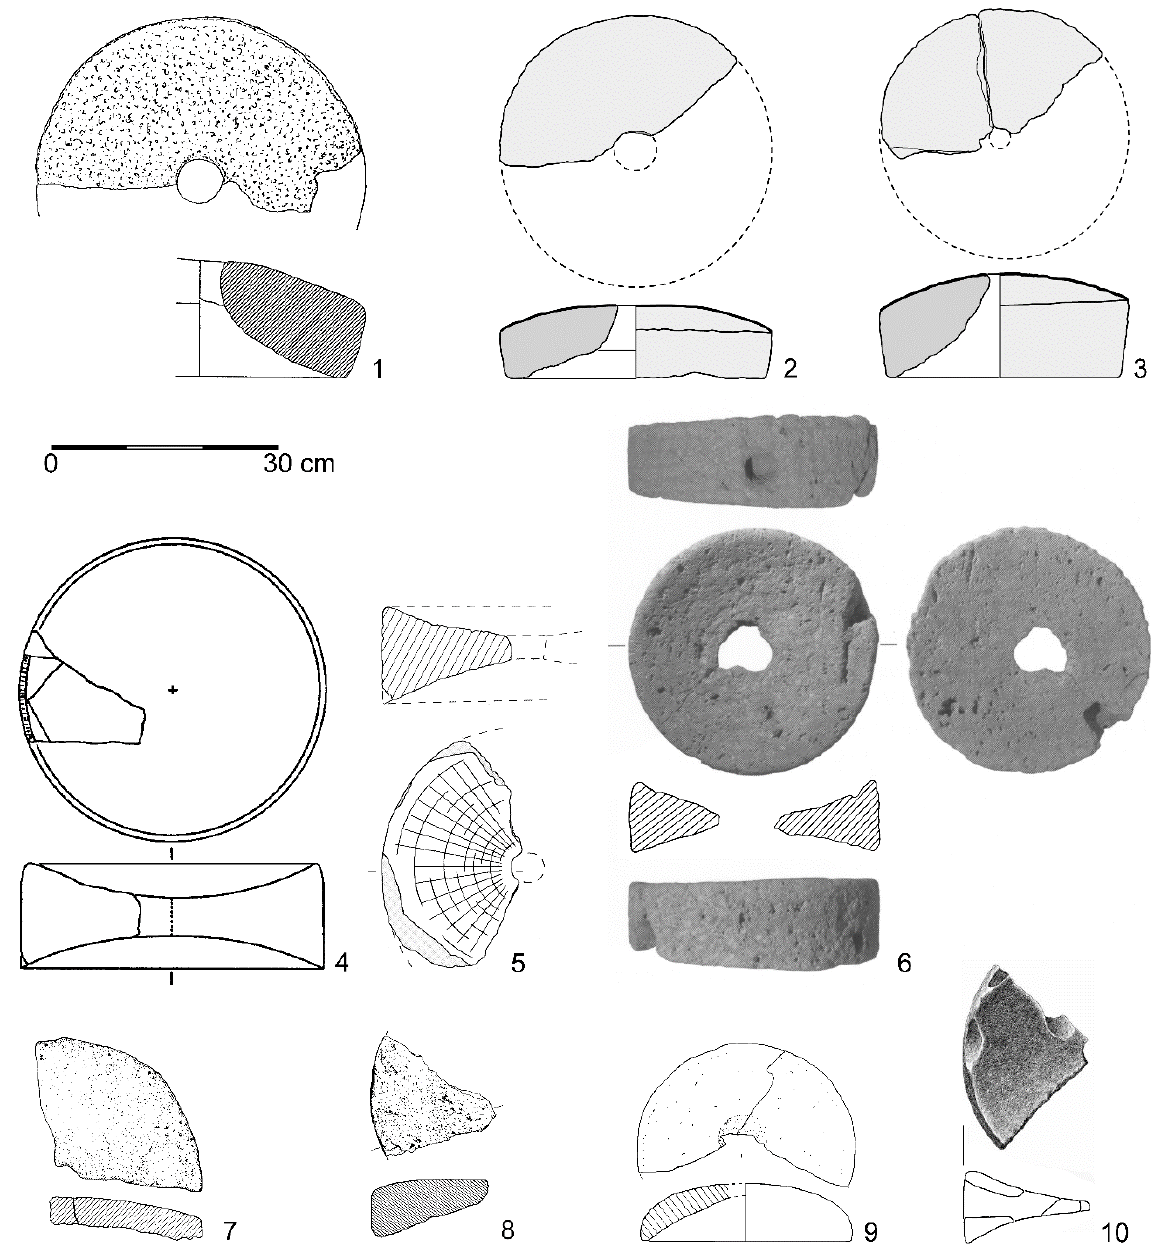
Figure 6. Iron Age quernstones of Brillerij type. 1-3, 7-9: lower stones; 4-6, 10: upper stones. Provenances: 1. Saffig, “Im Weidenfeld”; 2-3. Dannenfels, oppidum Donnersberg; 4. Heidetränk-Oppidum; 5. Hommerts- hausen, “Eisenköpfe”; 6. Geldermalsen-Hondsgement; 7. Sünninghausen, 8. Oss-Ussen, Westerveld, 9. Creil; 10. Oss, Brabantstraat. All volcanic rock. (1. Hörter 2000: fig. 2:5; 4 Staubitz 2007: pl. 1:1; 5. Wefers 2012a: pl. 41:216; 6. van Pruissen & Kars 2009: fig. 10.9; 7. Wilhelmi 1973: pl. 11:246; 8. Schinkel 1998: fig. 127b; 9. Fémolant 1989: fig. 28:1; 10. Knippenberg 2001: Fig. 61). Finds from pit 3 in the oppidum “Fosse des Pandours” near Saverne in France (List,